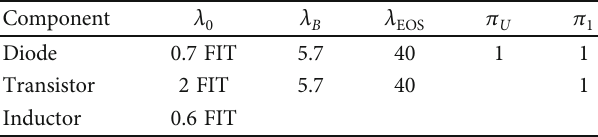
Table 10: Adjustment factors for power components.